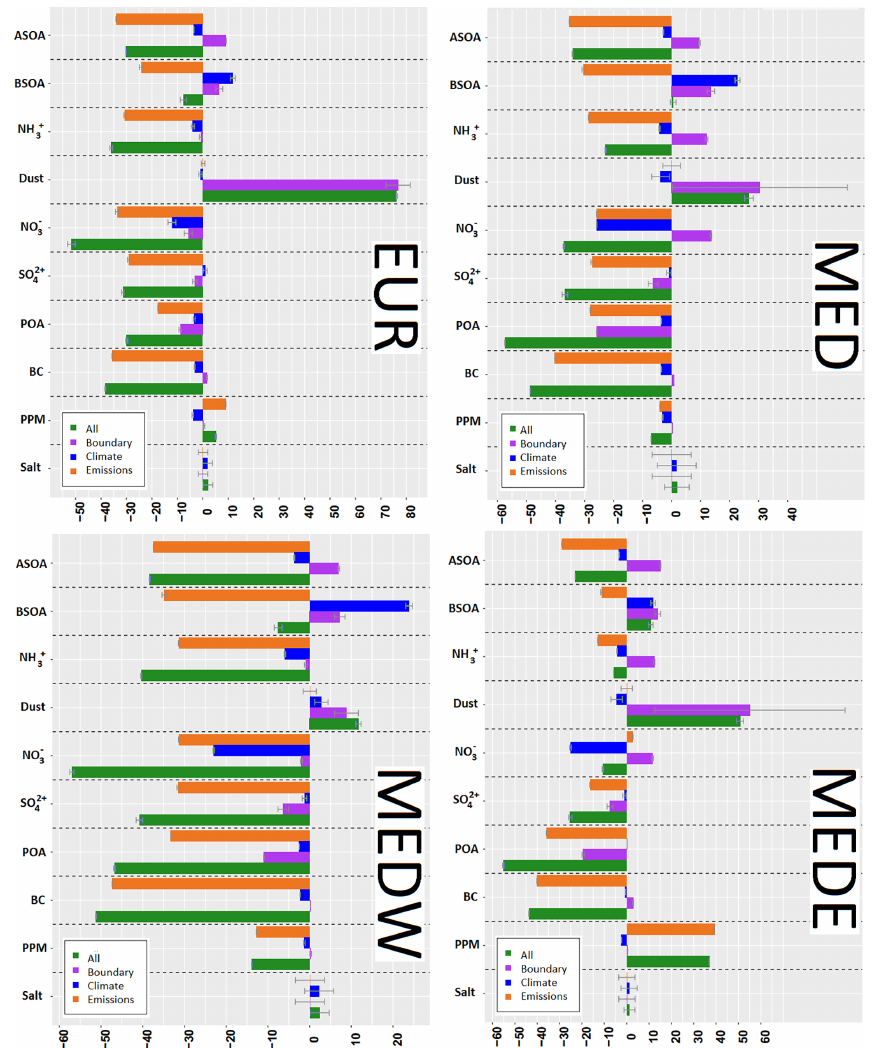
Figure 12. Relative impact of climate, boundary conditions and emission drivers on PM 10 components for different subdomains. Error bars show the confidence interval calculated on annual